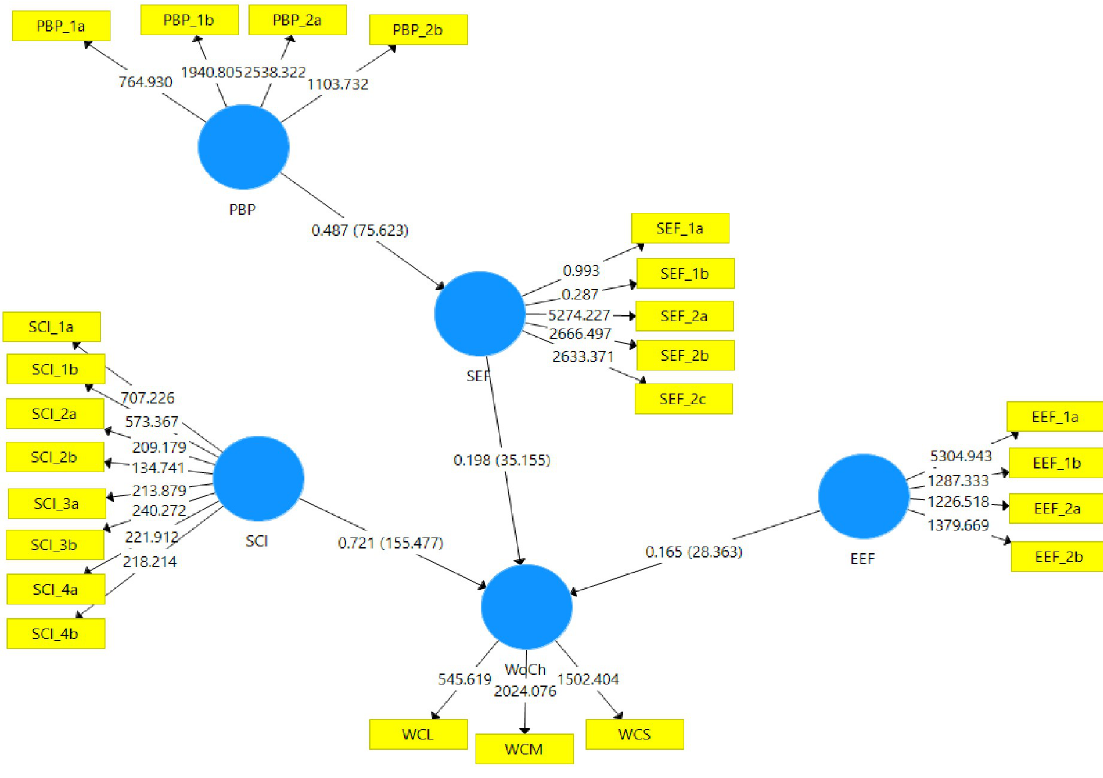
Fig 2. Hypotheses test